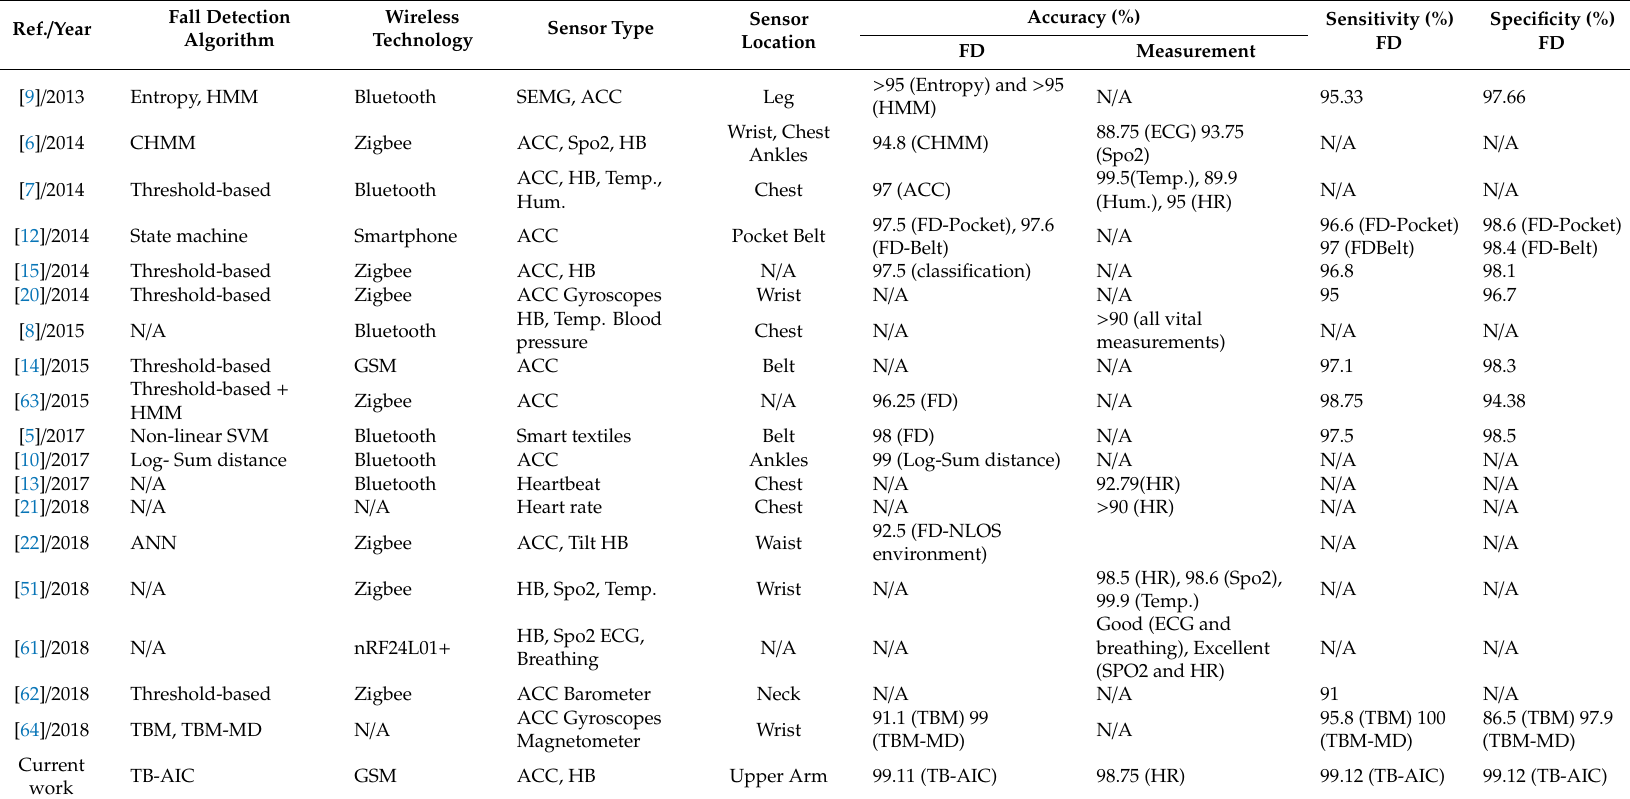
Table 5. Comparison of accuracy for FD and HR measurement with related